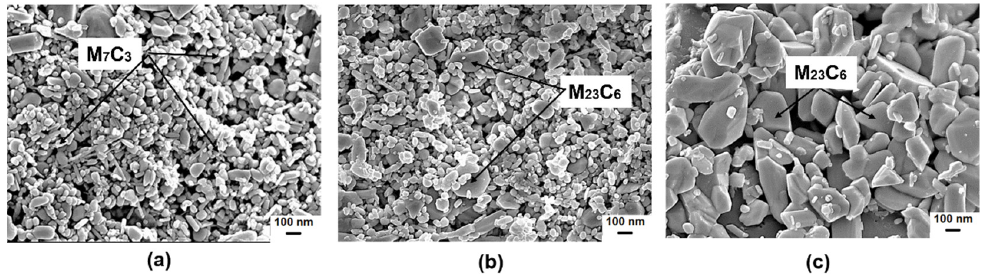
Figure 5. SEM micrograph of extracted residues of the steel after aging at 600 °C for ( a ) 0, ( b ) 300 and ( c ) 7000 h.